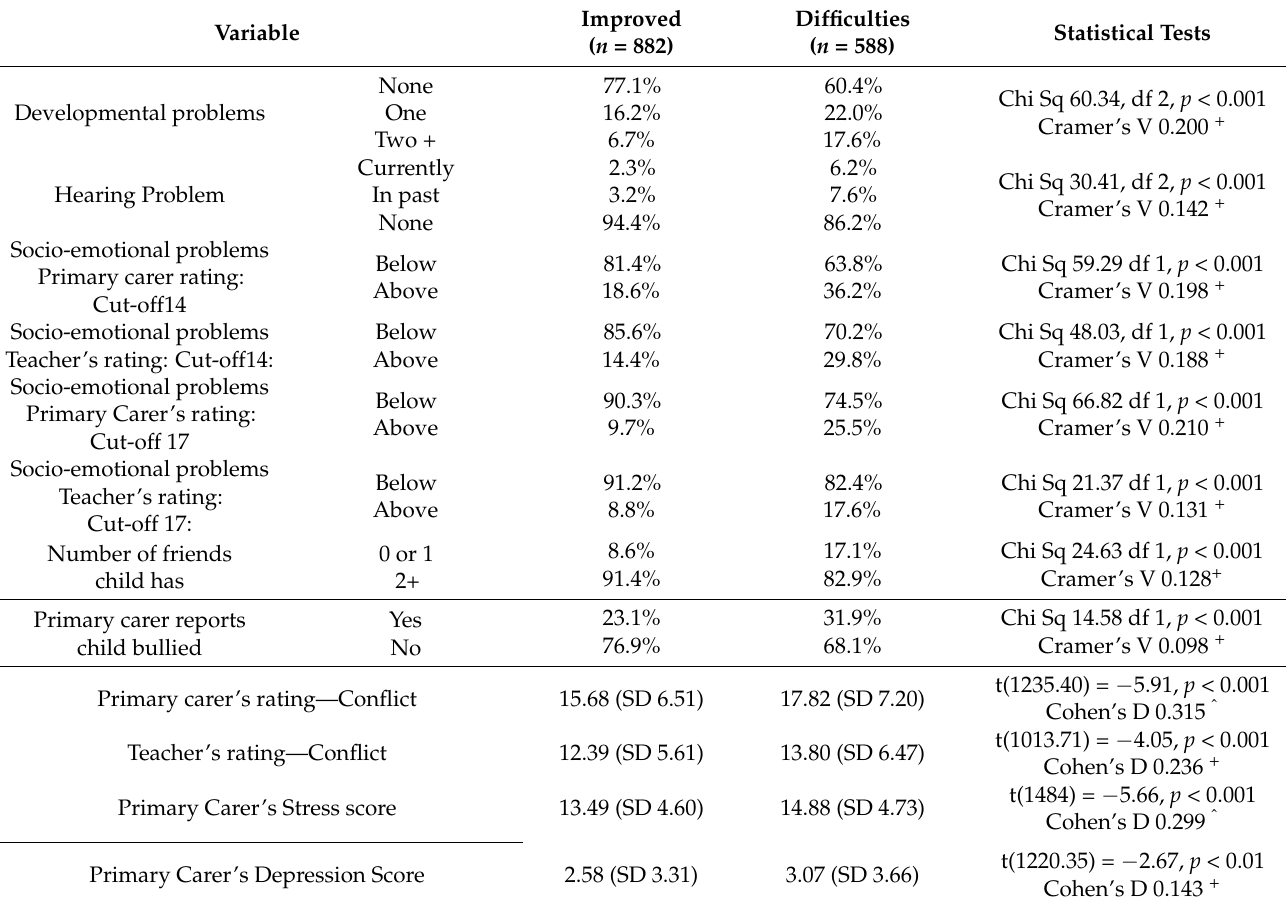
Table 3. The contrasts between children who had improved at age 9 compared to those with difficulties at age 9. Variable